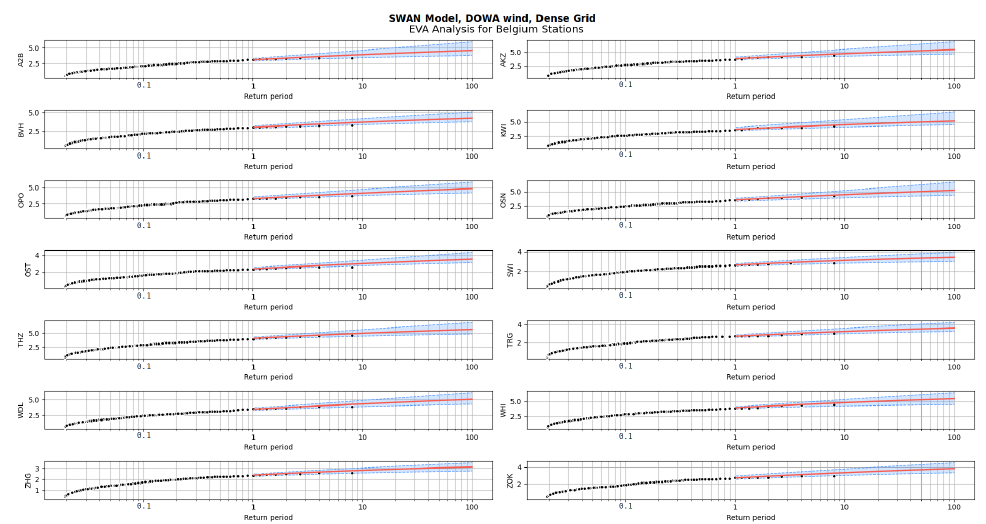
Figure 15. Linearised General Extreme Value Analysis plots for calculated significant wave height vs. return period (years) for the DOWA forced calibrated SWAN modelled significant wave heights at various Belgian stations computed on the 2.5 km grid.